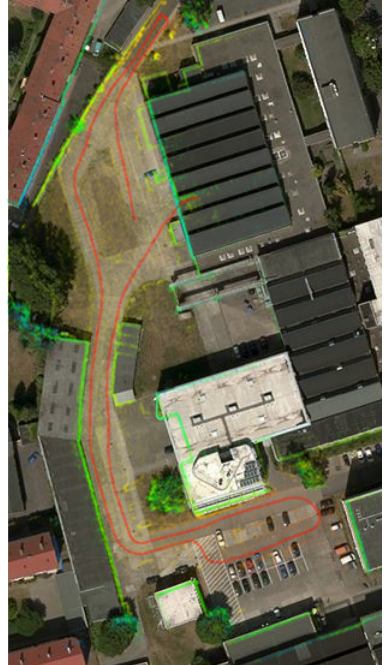
Table 1. Simultaneous exploration with UGV and UAV